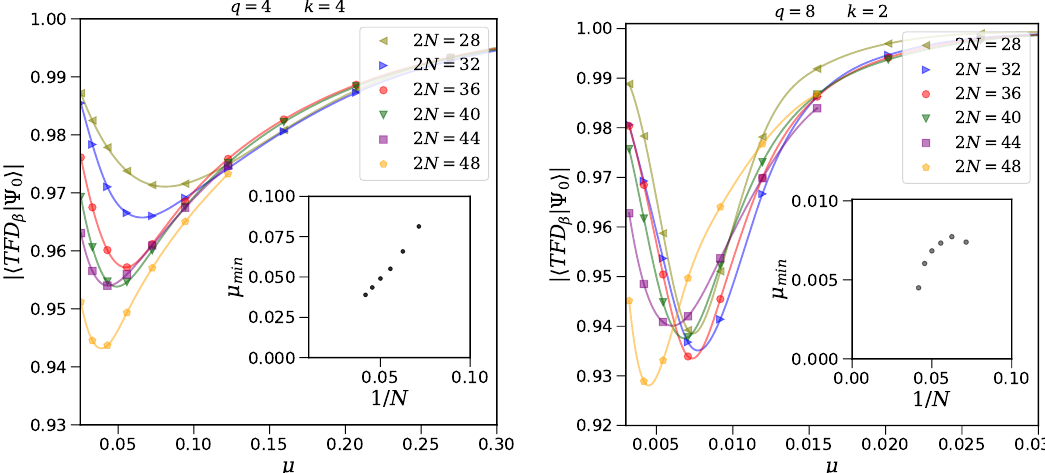
Figure 6. Main: maximum overlap between the ground state of two coupled sparse SYK model and the TFD, assuming that both states are normalized. Inset: finite N scaling for the value µ min at which the overlap reaches its minimum. We set q = 4 , k = 4 (Left) and q = 8 , k = 2 (Right), and performed an average over 50 disorder